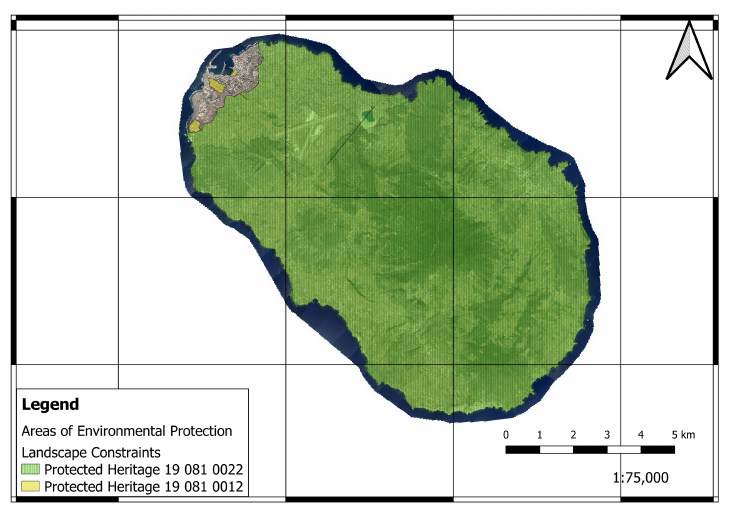
Figure 5. Landscape